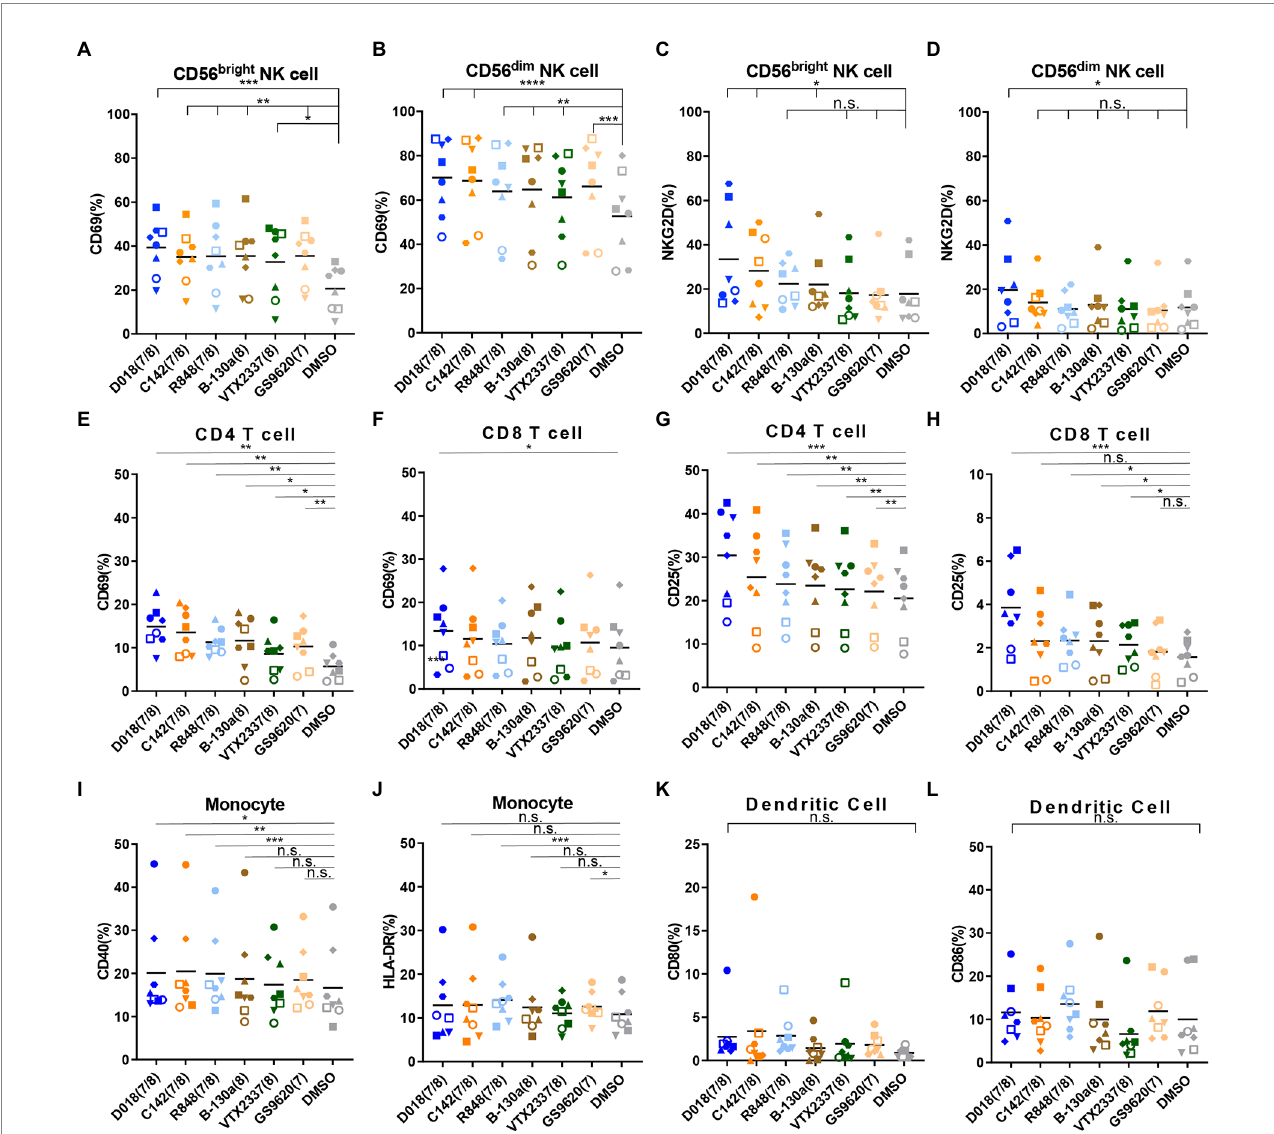
FIGURE 6 TLR7/8 agonists prefer to induce the NK cells and T cells activation and IFN- γ expression. (A–D) PBMCs from healthy donors were stimulated by different TLR7/8 agonists or DMSO for 24 h, and different activated markers in several immune cells were analyzed by flow cytometry. The percentage of (A) CD69 positive CD56 bright NK cells and (B) CD56 dim NK cells, (C) NKG2D positive CD56 bright NK cells, and (D) CD56 dim NK cells. (E–H) The percentage of (E) CD69 positive CD4 T cells and (F) CD8 T cells, (G) CD25 positive CD4 T cells, and (H) CD8 T cells. (I,J) The percentage of (I) CD40 positive and (J) HLA-DR positive monocytes. (K,L) The percentage of (K) CD80 positive and (L) CD86 positive dendritic cells. Each different shaped point represents one donor and data is shown as the mean of 8 donors. Statistical difference between various TLR7/8 agonists and DMSO group was analyzed by paired t -test. **** p < 0.0001, *** p < 0.001, ** p < 0.01, * p < 0.05, n.s. not